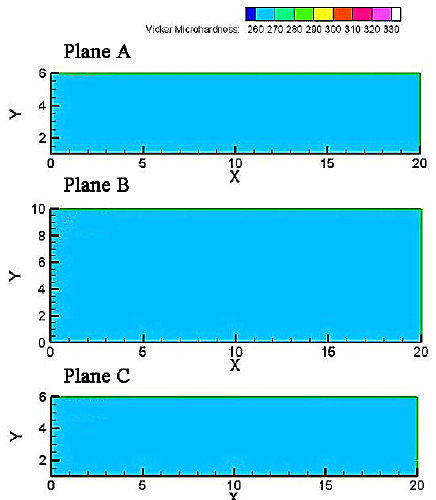
Figure 7. Color-coded contour maps showing Vickers microhardness distributions at solution treated sample before deformation along various planes.